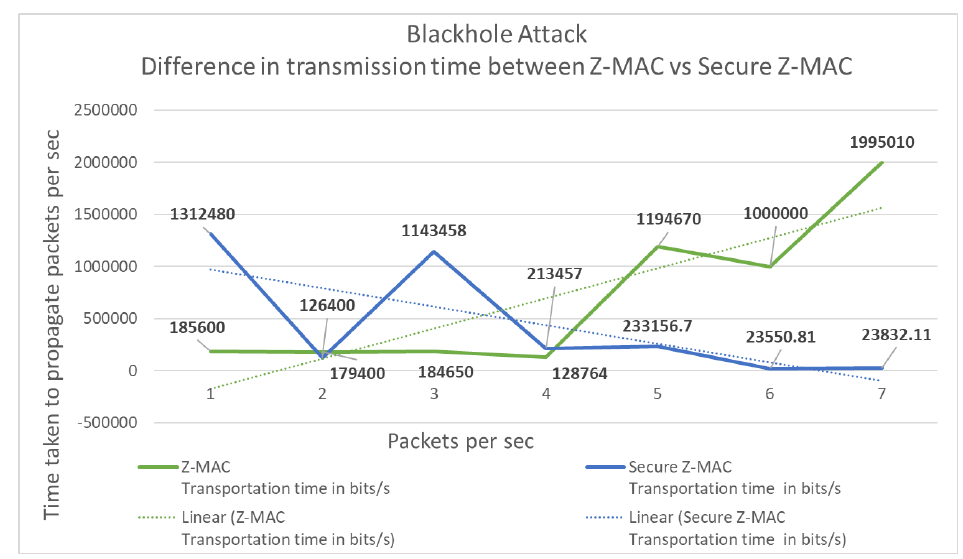
Figure 12. Graph simulating the transmission time during a blackhole attack against the packets transmitted in byte format in the secure Z-MAC scheme compared to Z-MAC. Table 8. Total transmission time during a blackhole attack for nodes processed using the secure ZMAC scheme compared to Z-MAC.